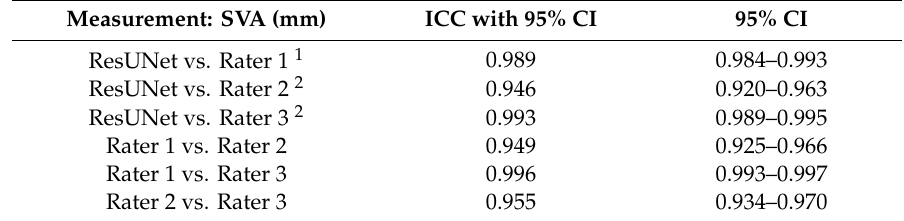
Table 5. The intra-class correlation coefficient (ICC) and its 95% confidence interval (CI). The ICC values were evaluated for different pair of estimators.